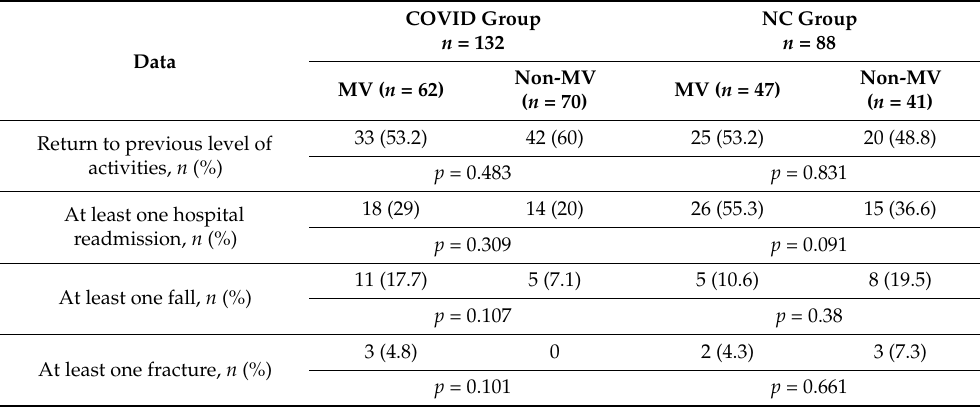
Table 3. One-year outcomes in the COVID and NC groups, whether patients required mechanical ventilation or not during their ICU